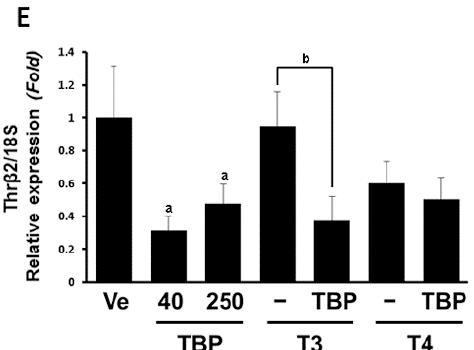
Figure 1. Expression levels of Dio1 ( A ); Dio2 ( B ); Gh ( C ); Tsh β ( D ) and Thr β 2 ( E ) mRNA in the pituitary gland. Results presented in the bar graph are divided according to chemical administered and subdivided according to the presence or absence of 2,4,6-tribromophenol. Ve, vehicle; T3, triiodothyronine; T4, thyroxine; TBP, 2,4,6-tribromophenol. a p < 0.05 versus vehicle, b p < 0.05 versus without TBP. Data are presented as the mean ± SD.